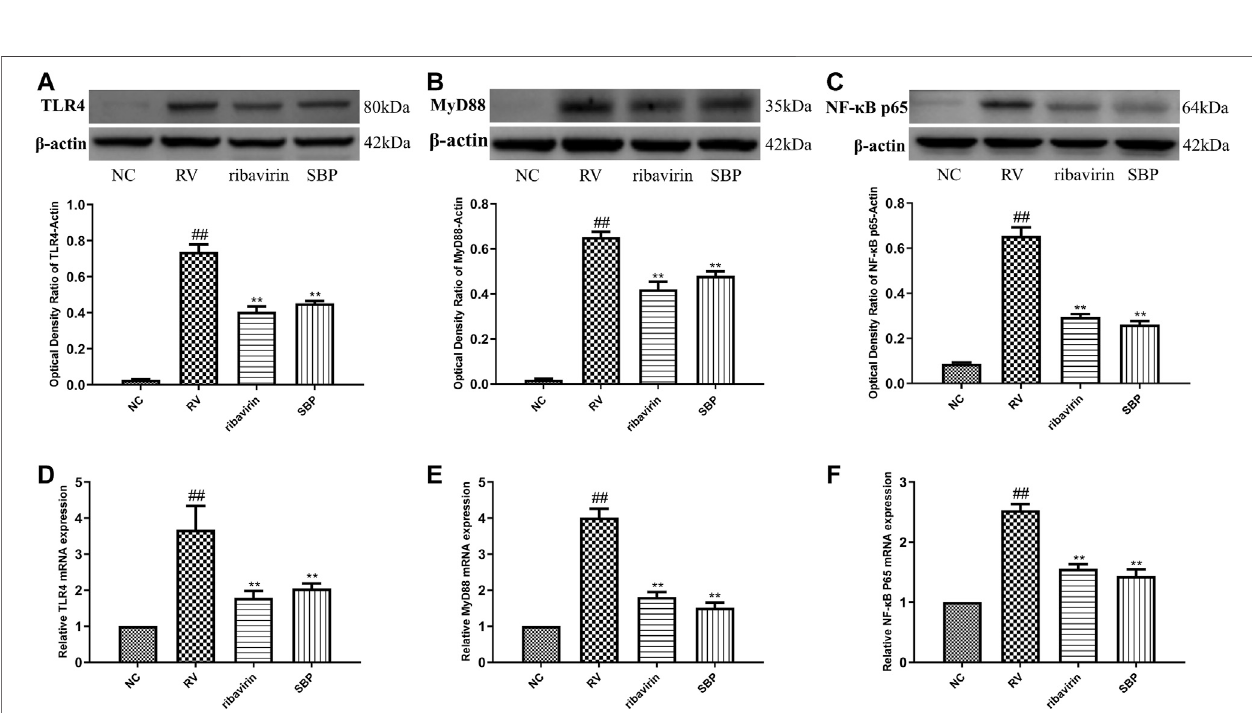
FIGURE4| ThemRNAandproteinexpressionsofTLR4,MyD88,andNF- κ Bp65 (A – C) WesternblotwascarriedouttomeasuretheexpressionsofTLR4,MyD88, and NF- κ Bp65,and ImageJ1.8.0 112software wasused toanalyzeand transform thestatisticaldataofalltheproteins (n (cid:2) 3) (D – F) RT-qPCRformRNAexpression of TLR4, MyD88, and NF- κ B p65 ( n (cid:2) 3). All values were presented as mean ± SD. ## p < 0.01 vs. NC group; *P < 0.05, ** p < 0.01 vs. RV group.